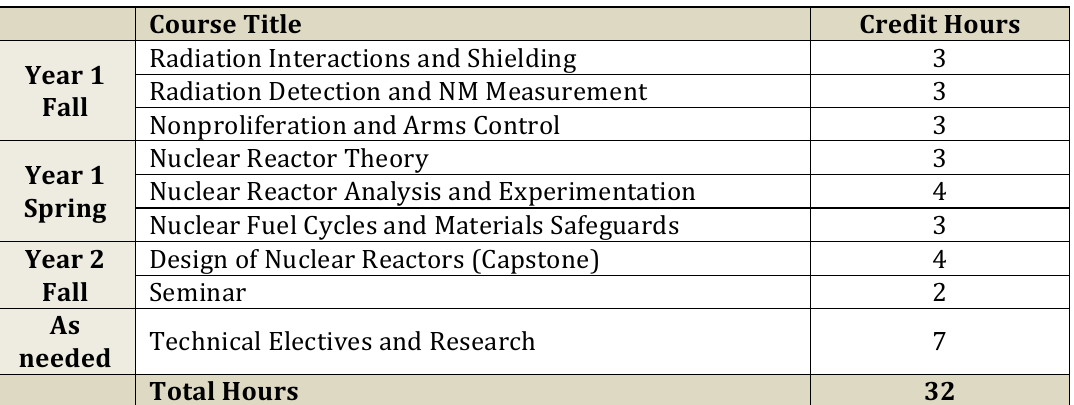
Table 1. MS-NNP Degree